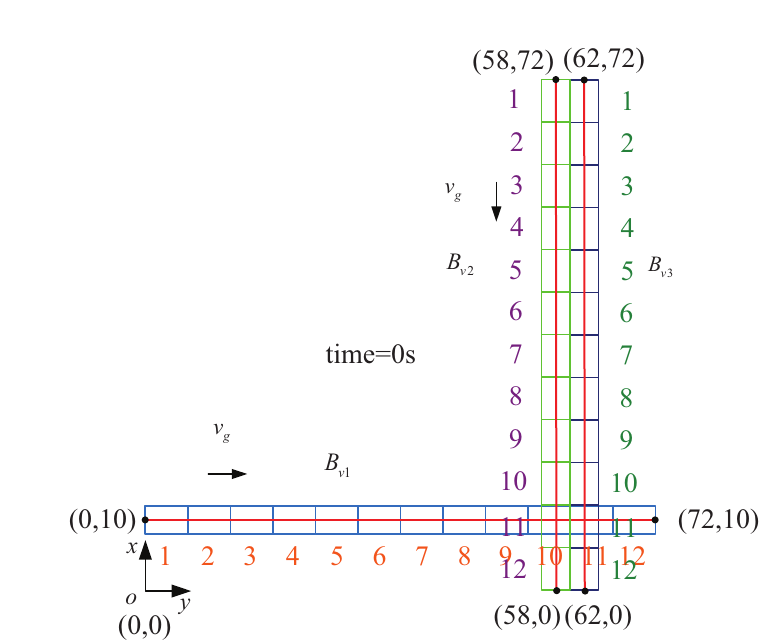
Figure 12. Collision checking of three